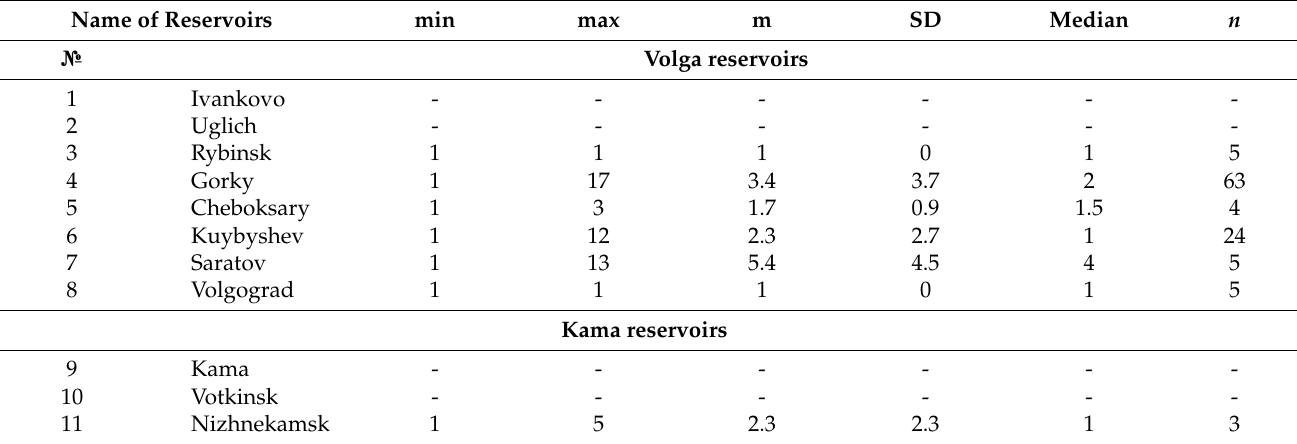
Table 6. The size of groups of the Pallas’s Gull ( Ichthyaetus ichthyaetus ) on the Volga–Kama reservoirs in the summer-autumn period,